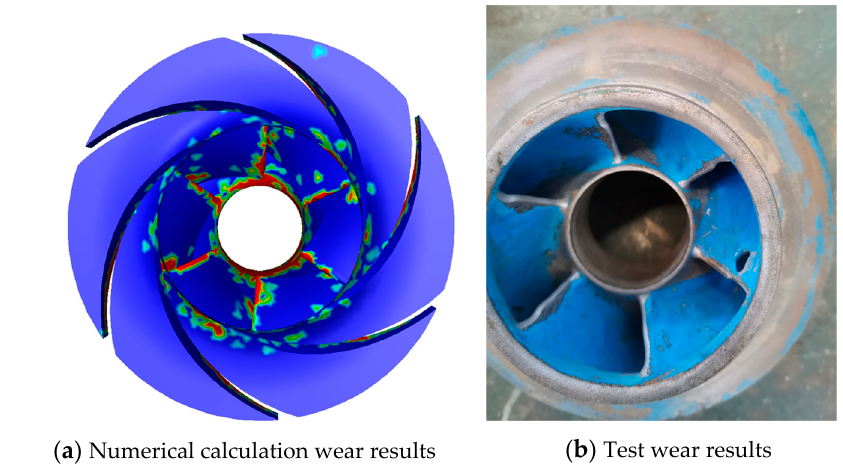
Figure 27. Comparison of the wear at the inlet of the test pump. Figure 28 is a comparison of the wear results of the first stage guide vane. Figure 29 is a comparison of the wear results of the secondary guide vanes.